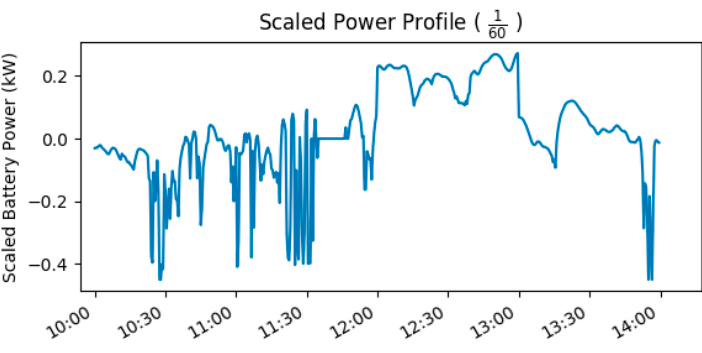
Figure 11. Scaled power profile for solar correction.